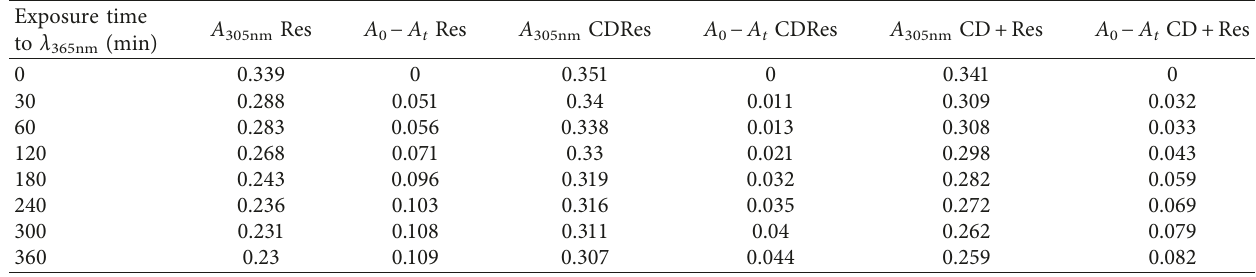
Table 1: Absorbance at 305nm of resveratrol (Res), CDRes, and inclusion complex of CM- β -CD with Res after exposure to UV radiation at 365nm.